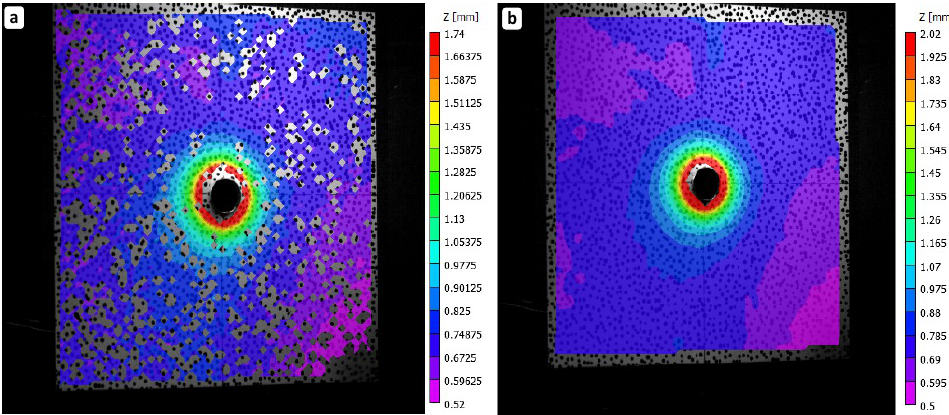
Figure 3. Out-of-plane displacements obtained after DIC calculations (configuration 2) using subset sizes of: ( a ) 9 and ( b )